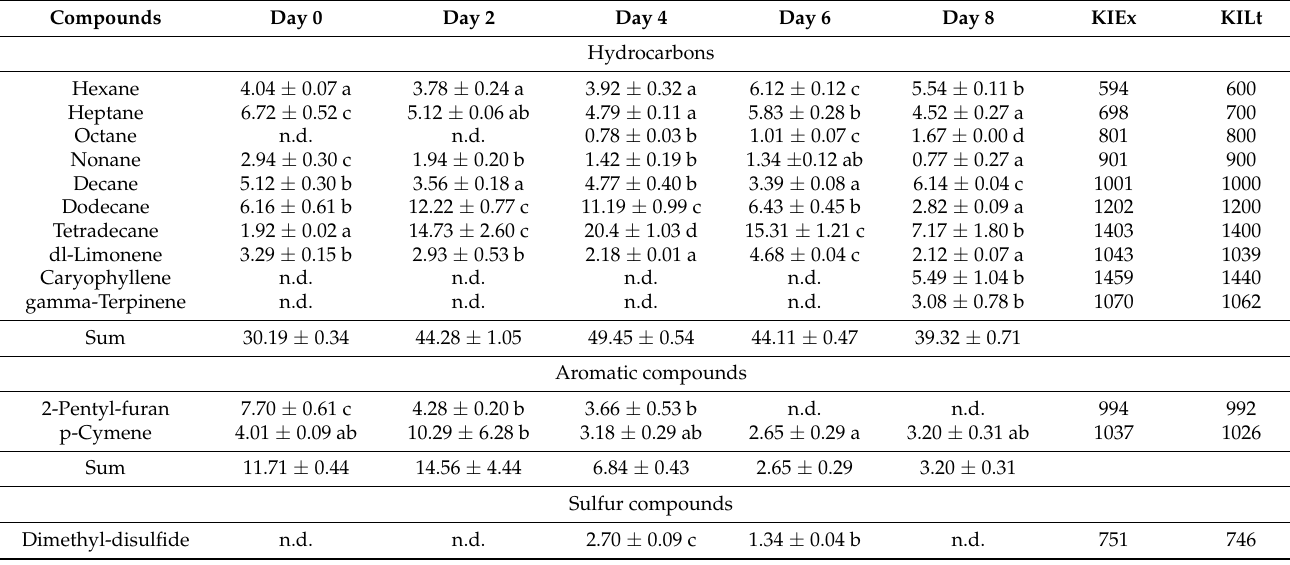
n.d. = not detected. The values are the means of 6 measurements, (n = 6) ± S.D., a.b.c Means with different letters in the same row are statistically different ( p < 0.05), KIEx = Kovac Index experimentally determined data, KILi = Kovac Index literature data, Nist 05, J. Wiley &